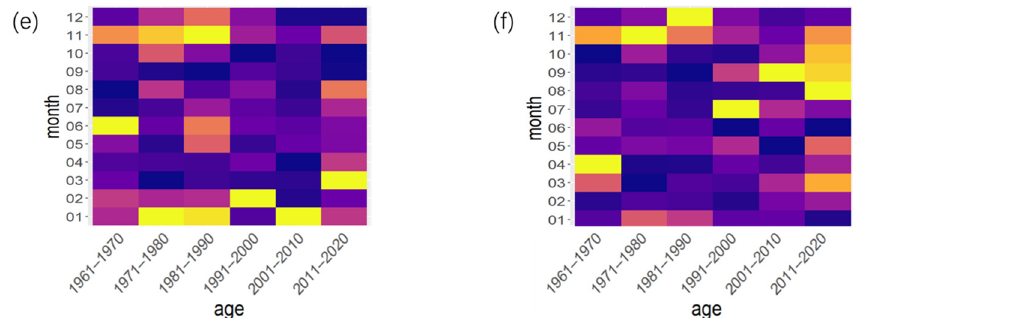
Figure 13. The distribution of the earliest occurrence date and the latest extinction date of heat waves